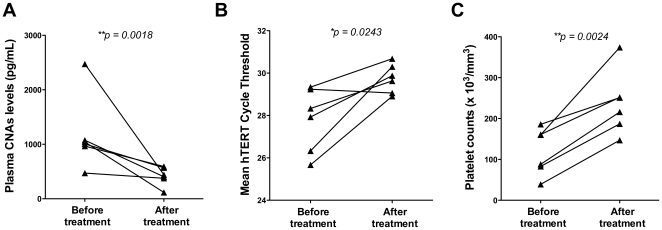
Plasma CNAs levels decrease after anti-malarial chemotherapy.For 6 patients who showed up during convalescence, the CNAs levels in plasma were assessed by (A) fluorescence quantification of dsDNA with the Pico Green methodology or (B) comparison of the mean cycle threshold for the qPCR amplification of hTERT genomic sequence. (C) platelet counts measured during admission and convalescence. Statistics were performed as follow: Mann-Whitney test for panel A, and two tailed t test for panels b and C. A p value<0.05 was considered significant.